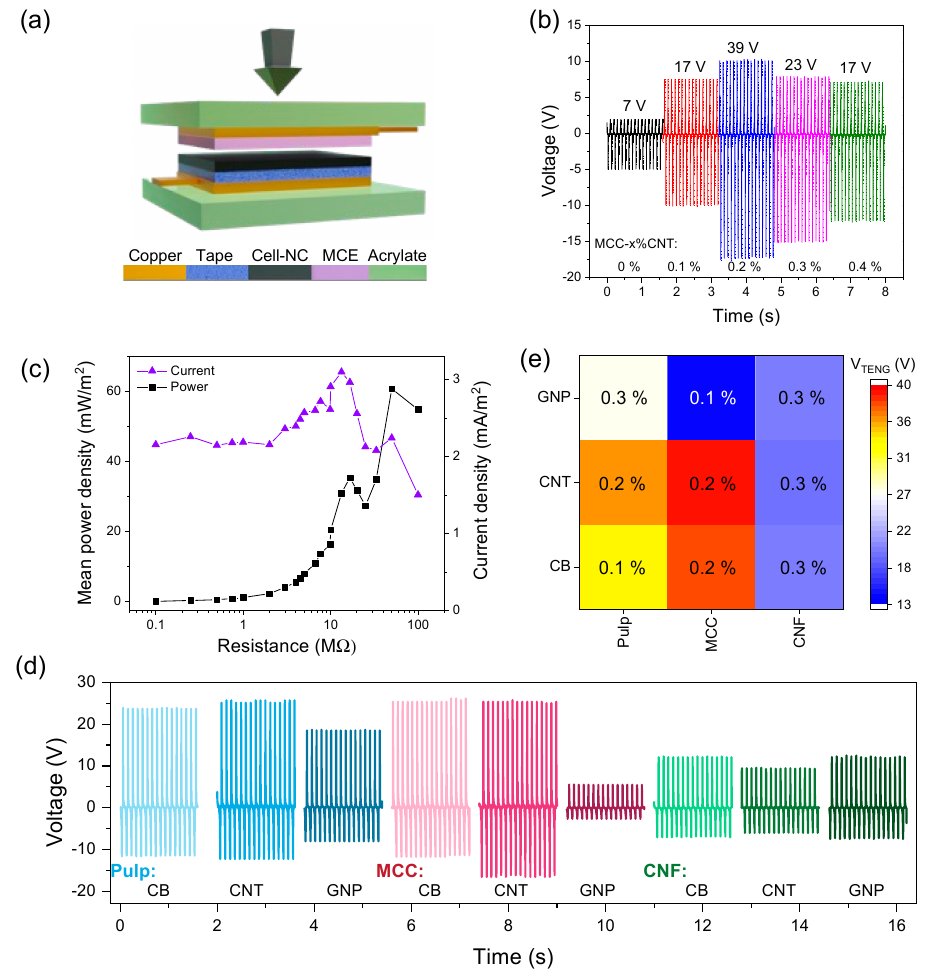
Figure 5. Triboelectric harvesting measurements. Illustration of the contact–separation mode TENG with MCE and the cellulose–nanocarbon (Cell-NC) nanocomposite films as triboactive components ( a ). Triboelectric output voltage of MCC as a function of the CNT filler content ( b ). Power and current density curves of MCC-0.2%CNT ( c ). Output voltage of all cellulose–nanocarbon combinations ( d ). Heat map of the maximum triboelectric output voltage at the optimum nanocarbon content of each cellulose–nanocarbon combination ( e ).